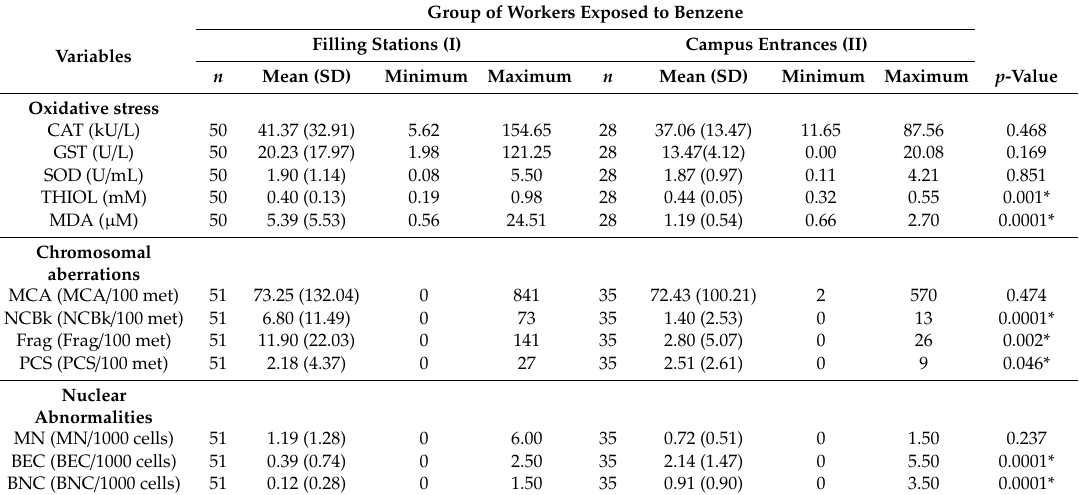
Figure 3. Plot of linearity between leukocyte count and tt MA. Linear relationship [F(2,66) = 2.970, p = 0.058, R 2 = 0.083] between leukocyte count and tt MA ( β = 5169, p = 0.031), using age as the control variable. Table 4. Results of the biomarkers of oxidative stress and chromosomal and nuclear anomalies of the two groups of workers exposed to benzene.